Question: In a single sentence, describe what this figure presents.
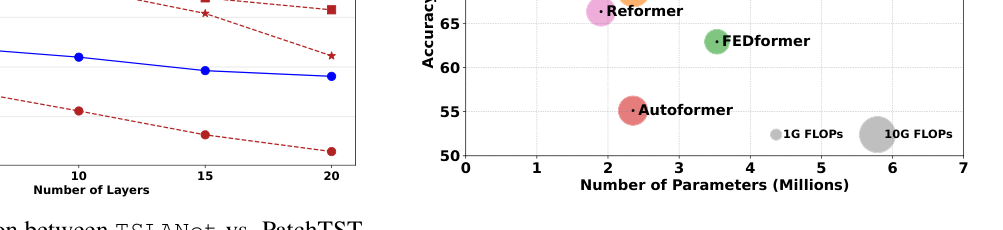
Answer: TSLANet vs. baselines in terms of the number of parameters and FLOPS count against the classification accuracy of the UEA Heartbeat dataset.